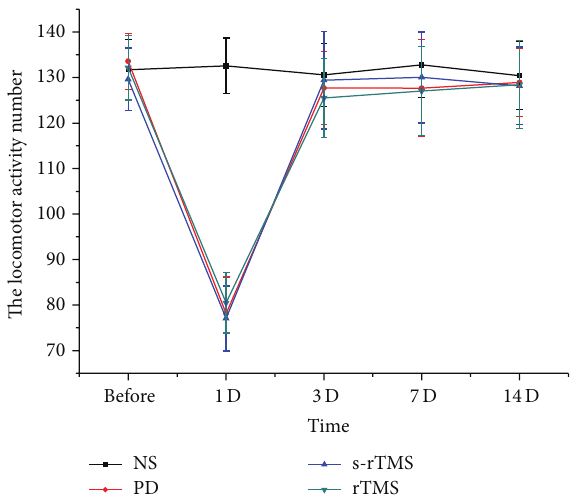
Figure 4: The effects of low-frequency rTMS on the content of DA and its metabolites in the striatum of PD model mice. ∗ Significantly different from NS group, 𝑃 < 0.05 ; # significantly different from rTMS group, 𝑃 < 0.05 .